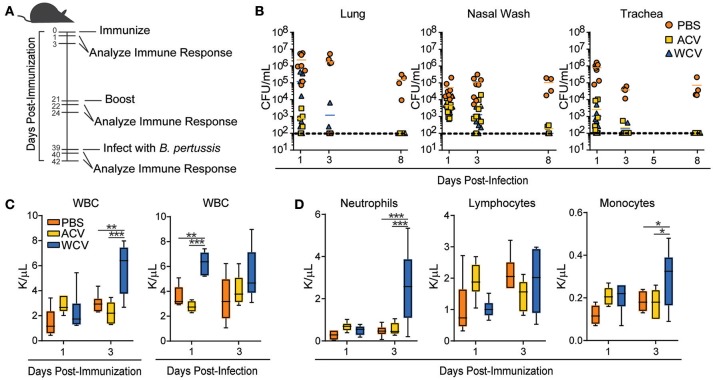
Vaccine content determines PB immune response to Bp challenge. (A) The workflow for immunization and infection schedules of 5-weeks-old female CD-1 mice is represented. Mice were immunized with phosphate buffered saline (PBS), Bp acellular vaccine (ACV), or Bp whole cell vaccine (WCV) and infected with 2 × 107 CFU UT25 Bp. Immune responses in mice were evaluated at 1 and 3 days after immunization, boost, and infection. (B)
Bp bacterial burden was measured in lung, nasal wash, and trachea of mice (n = 4–8/group for each time point) by counting CFUs produced 3 days after plating and incubating serial dilutions of homogenates on BG containing streptomycin (100 μg/ml) at 37°C. (C) White blood cell counts were measured (n = 5–6/group for each time point) on a Drew Scientific Hemavet 950 at days 1 and 3 post-immunization and days 1 and 3 post-infection **p < 0.01; ***p < 0.001. (D) Differential white blood cell counts measured on days 1 and 3 post-immunization are represented. *p < 0.05; 2-way ANOVAs with Tukey's multiple comparisons. Bars extend to represent minimum to maximum values, while the line represents the mean.